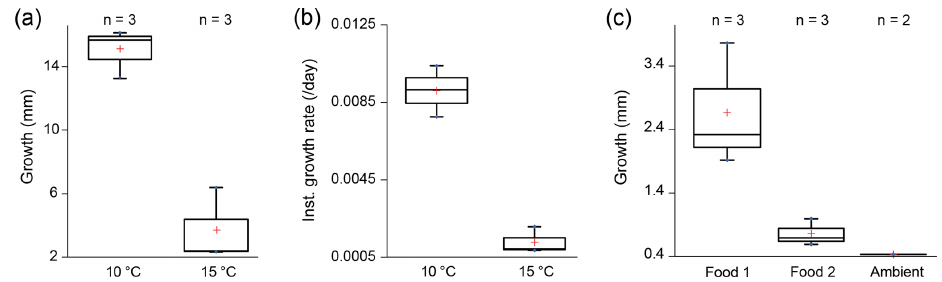
Figure 4. Arctica islandica shell growth under controlled conditions. (a) Total growth and (b) instantaneous growth rate during the tempera- ture experiment. (c) Total growth during the food experiment.